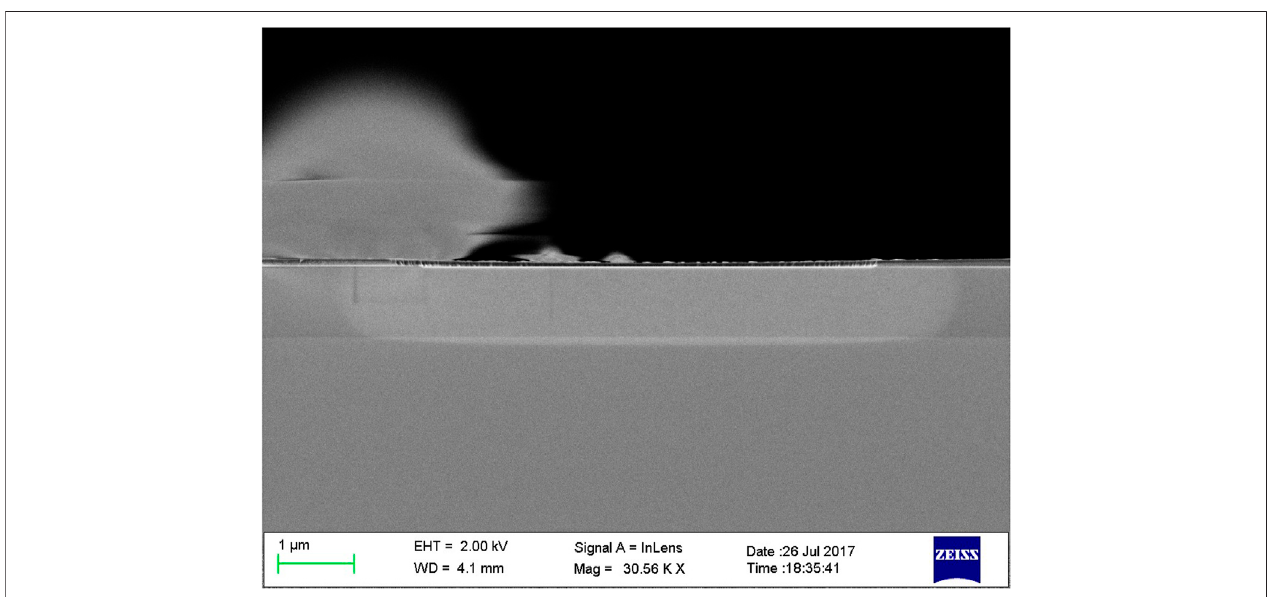
FIGURE 1 | Cross-section of Zn diffusion.